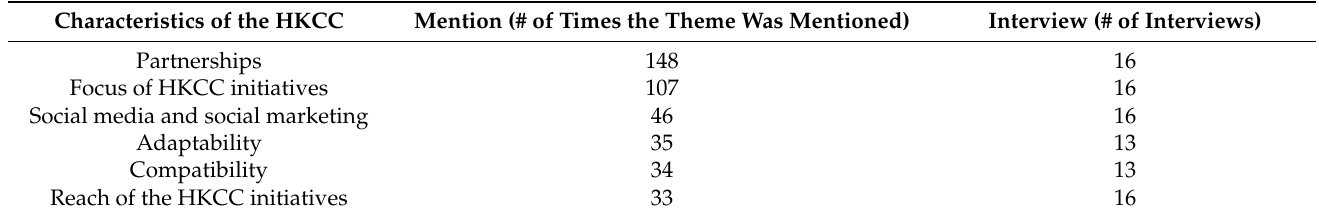
Table 2. Characteristics of the Healthy Kids Community Challenge (HKCC) program, as reported by interview participants. Characteristics of the